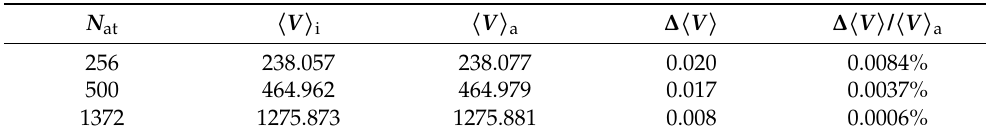
Figure 1. Volume average and fluctuations for an fcc Lennard-Jones crystal simulated with SimpleMD. Average ( a ) and variance ( b ) of the cell volume as functions of the barostat relaxation time τ P , setting n s = 1. Average ( c ) and variance ( d ) of the cell volume as functions of the multiple-time-stepping stride n s , setting τ P = 10. Insets in panels ( b , d ) are used to show the large τ P and low n s regimes, respectively. TR denotes the time-reversible integrator (see Section 2.3.2). Table 1. Differences between isotropic and anisotropic volume averages observed by simulat- ing Lennard-Jones crystals of different sizes with SimpleMD. N at is the number of atoms, (cid:104) V (cid:105) a and (cid:104) V (cid:105) i are the averages computed in the anisotropic and isotropic ensemble, respectively, and ∆ (cid:104) V (cid:105) = (cid:104) V (cid:105) a − (cid:104) V (cid:105) i . Volumes were measured in Lennard-Jones units. Simulations were carried out with τ p = 1, n s = 1 and with the same parameters described in Section